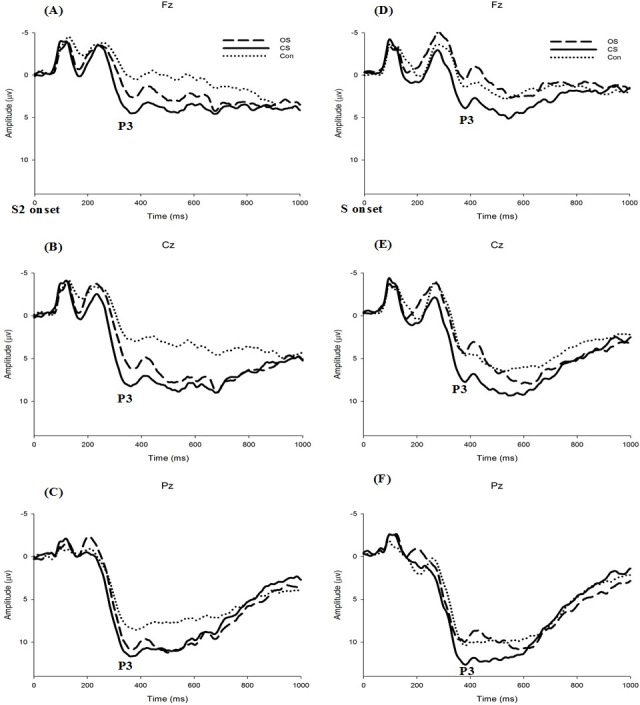
Grand average ERP at Fz, Cz, and Pz sites stratified by group for Delayed condition (A–C) and Non-delayed condition (D–F).